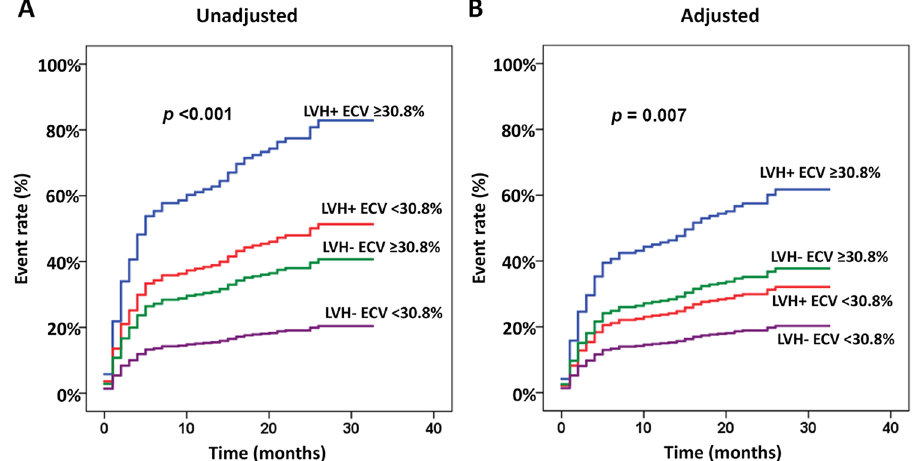
Figure 4. Cumulative incidence of cardiovascular event rate compared among LV hypertrophy (LVH) with extracellular volume (ECV) ≥ 30.8% (blue line), LVH with ECV < 30.8% (red line), no-LVH with ECV ≥ 30.8% (green line), and no-LVH with ECV < 30.8% (purple line): ( A ) unadjusted, ( B ) adjusted.